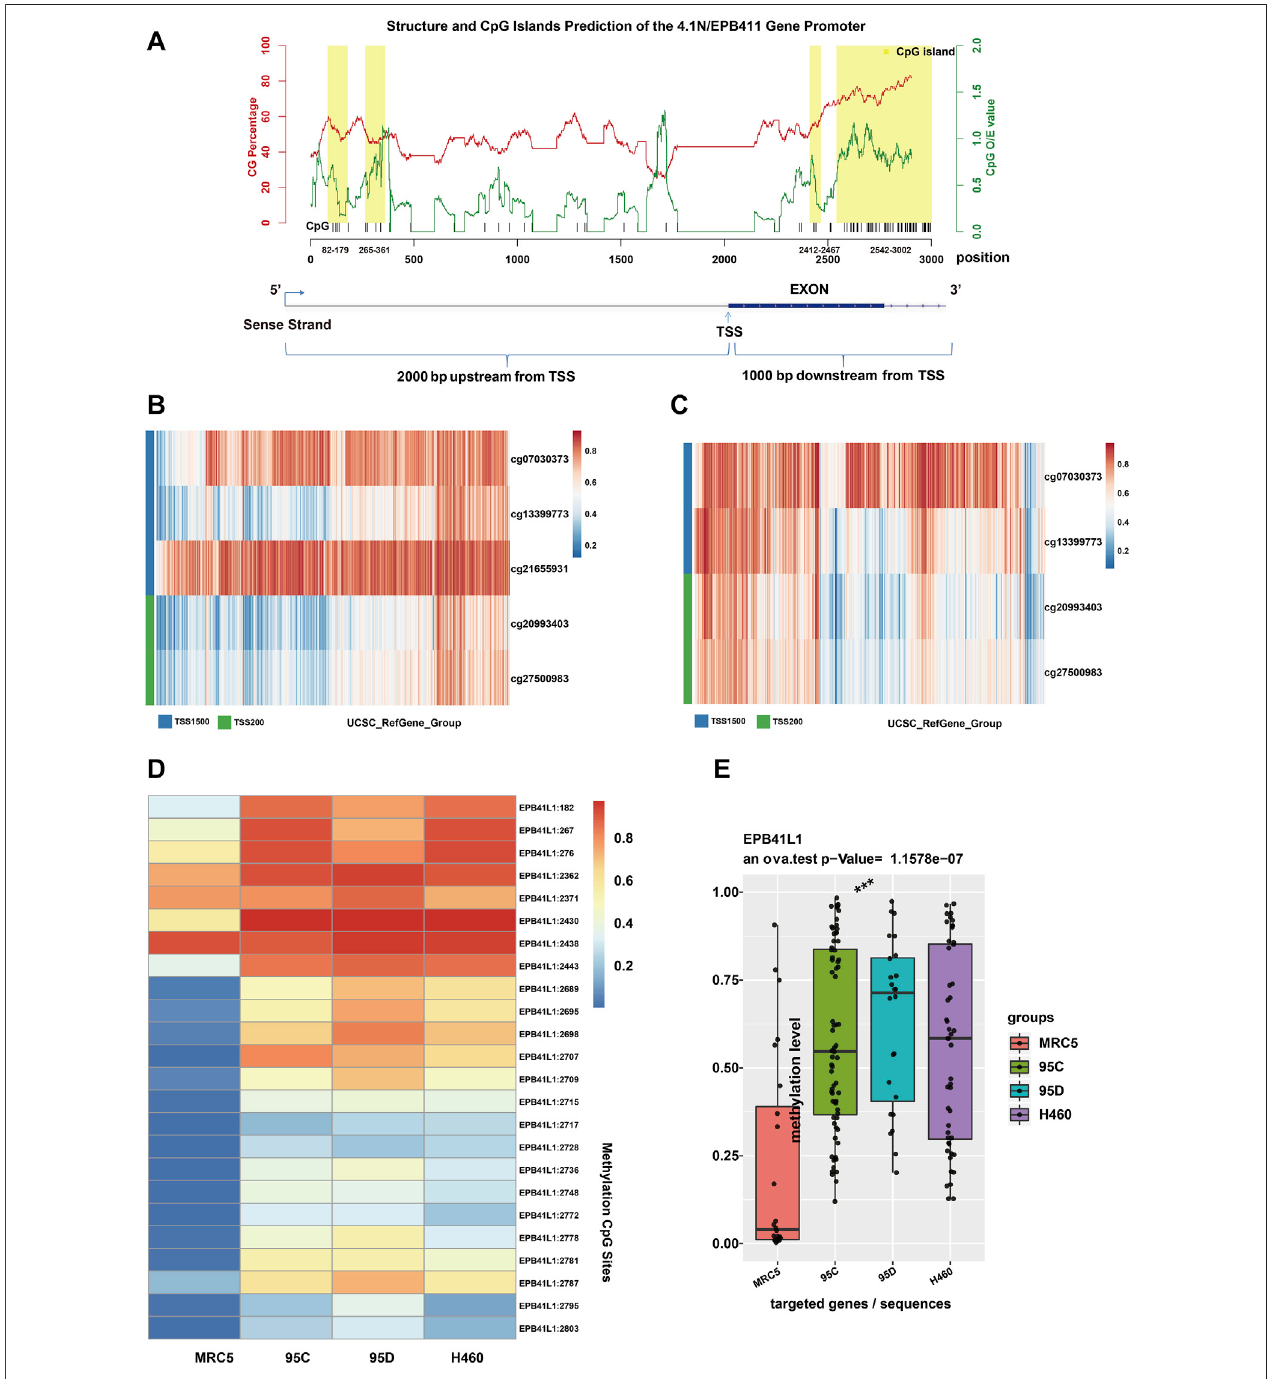
FIGURE 1 | Promoter methylation of the 4.1N/ EPB41L1 gene in NSCLC. (A) In the upper panel, CpG island prediction of the 4.1N/ EPB41L1 gene promoter was integrated using the CpGPNP program. The red line represented GC content, the green line represents CpG O/E value, and the yellow box represented four predicted locations of CpG island (range from 82 to 179, 265 – 361, 2412 – 2467, and 2542 – 3002, sequence length > 100 bp, GC content > 50%, O/E value > 0.6). The lower panel representedthestructureofthe4.1N/ EPB41L1 genepromoter(rangefromTSS-2000toTSS1000).Coordinatevaluesofabscissasinthelowerandupperpanels werecorrelated.TSS-2000inthelowerpanelcorrespondedto0intheupperpanel.TheTSSsiteinthelowerpanelcorrespondedto2000intheupperpanel.TSS1000 inthelowerpanelcorrespondedto3000intheupperpanel. (B,C) HeatmapdepictingtheCpGmethylationlevelofthe4.1N/ EPB41L1 genepromoterinLUADandLUSC patients.Rowsand columns representedthe CpGsand thepatients, respectively. (D) Heatmap depictingthe methylation levels ofthe4.1N/ EPB41L1 genepromoterin normal lung fi broblast cells MRC5 and LCLC cells (95C, 95D, and H460). The row label was the methylation site. The number of row labels corresponded to the coordinatevalueofabscissaintheupperpanelofPanel1A.Methylationlevelswererepresentedasbetavaluesandshownasacontinuousvariablefrombluetored.Any